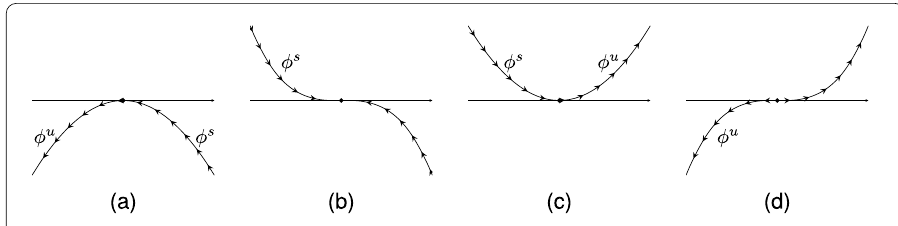
Figure 2 The invariant curves guaranteed by Theorem A. The horizontal line consists entirely of fixed points in a neighborhood U of the origin (the black